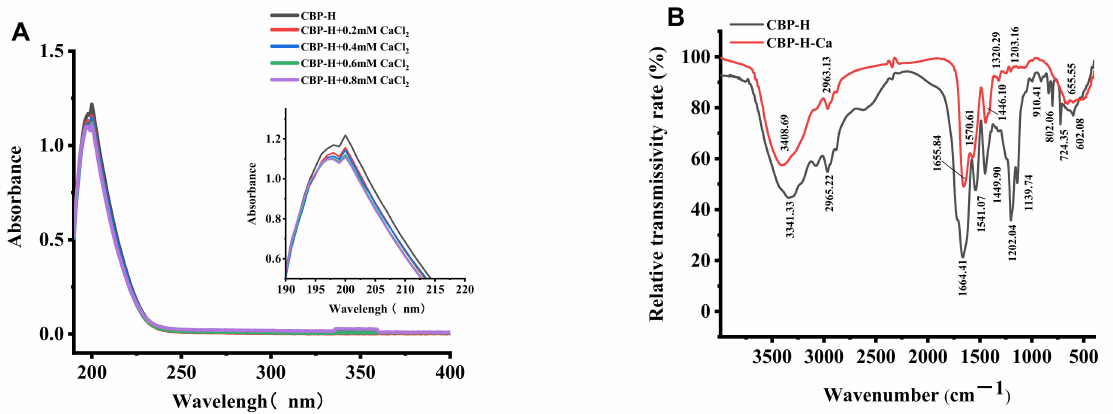
Figure 3. ( A ) UV spectra of CBP-H and CBP-H–Ca with wavelengths in the field of 190–400 nm. ( B ) FTIR spectra of CBP-H and CBP-H–Ca with wavelengths in the range of 190–400 nm.